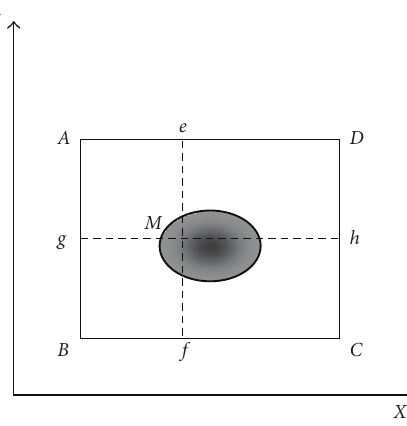
Figure 1: Interpolation description. The dark area represents lesion and others represent sound tooth structure. Thus, lines AB , BC , CD , and DA were seated on sound tooth structure and were used for